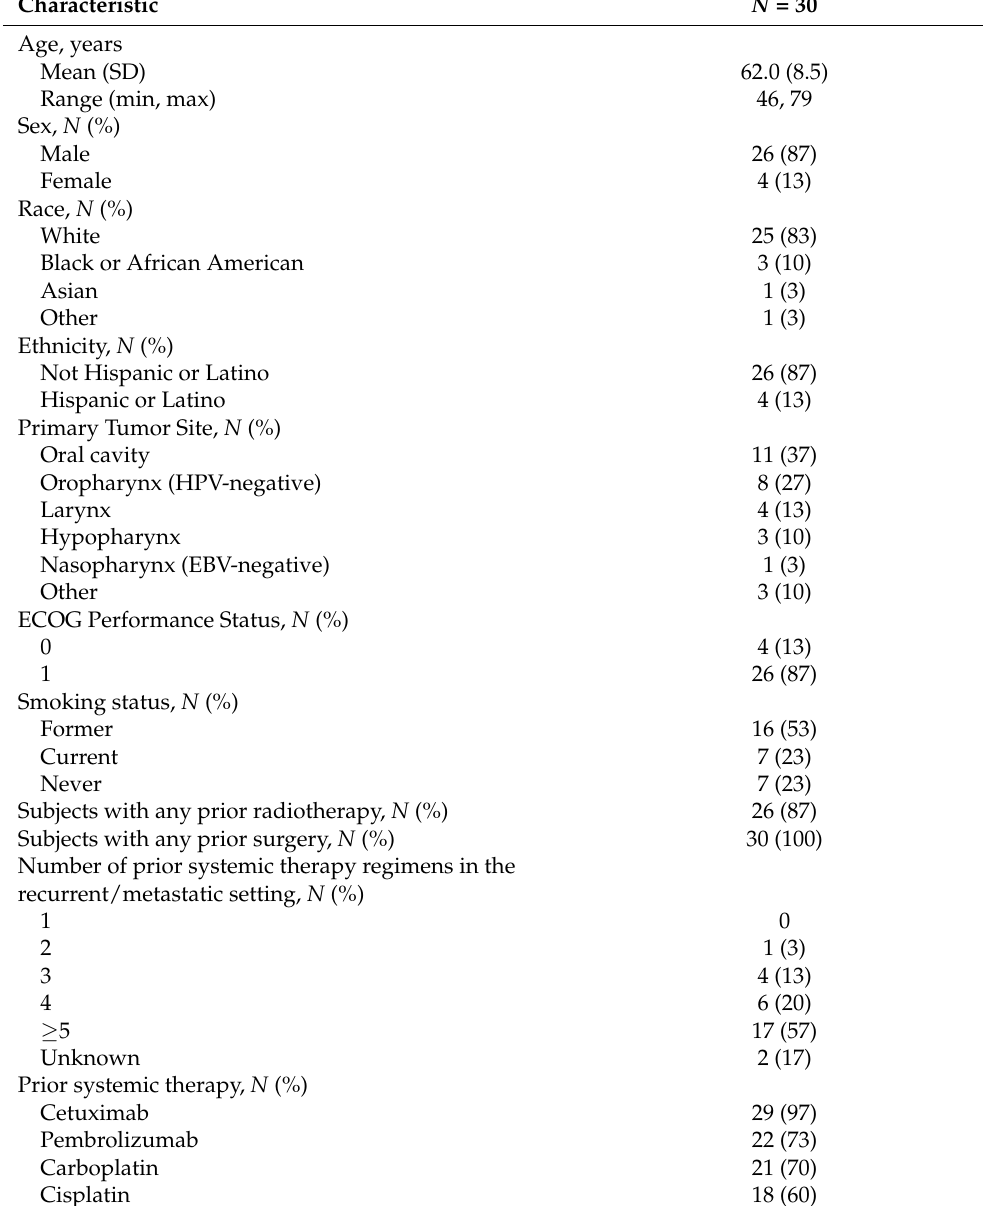
Table 1. Baseline patient